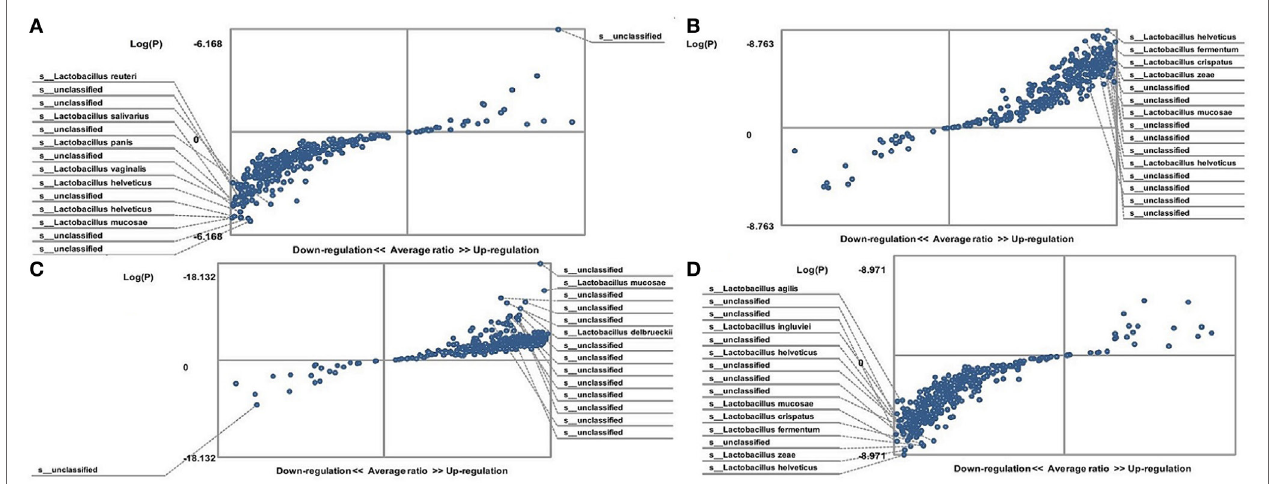
FigUre 2 | Distribution of gut lactobacilli in Candida albicans -carrier familial Mediterranean fever (FMF) patients. Contribution of variables to differentiation between two groups [ X axis, average ratio between two groups; Y axis, − Log(P)]. The upper-right and left-down corner are the most significant. (a) FMF women with gut C. albicans numbers above baseline level/FMF women with C. albicans below baseline level; (b) FMF men with C. albicans below baseline level/healthy men; (c) FMF women with C. albicans below baseline level/healthy women; (D) FMF men with gut C. albicans numbers above baseline level/FMF men with C. albicans below baseline